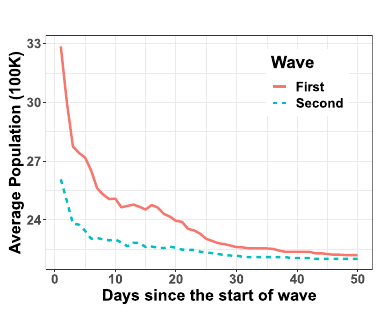
Figure 4. Variation of average population of Indian districts with cumulative number of ≥ 5 infections since the start of the waves as in Fig. 1b. Start dates of the two waves are 05/01/2020 and